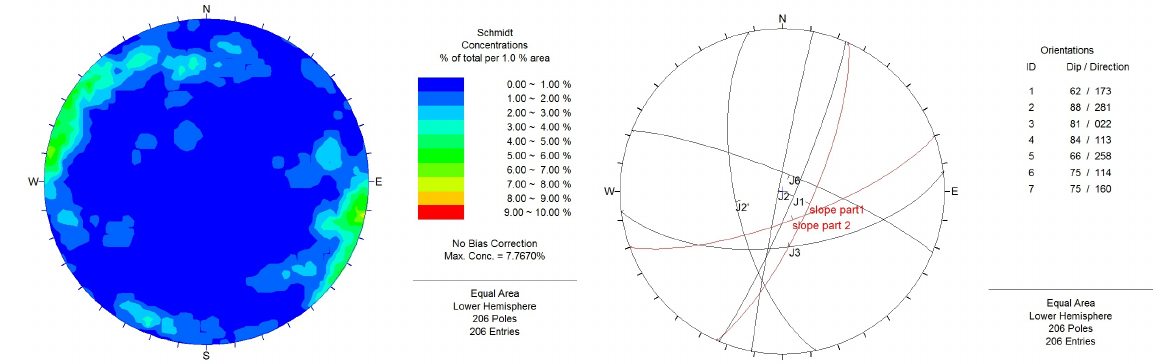
Fig. 4. Stereographic projection of main discontinuity sets and slope faces. Slope faces are denoted in red.